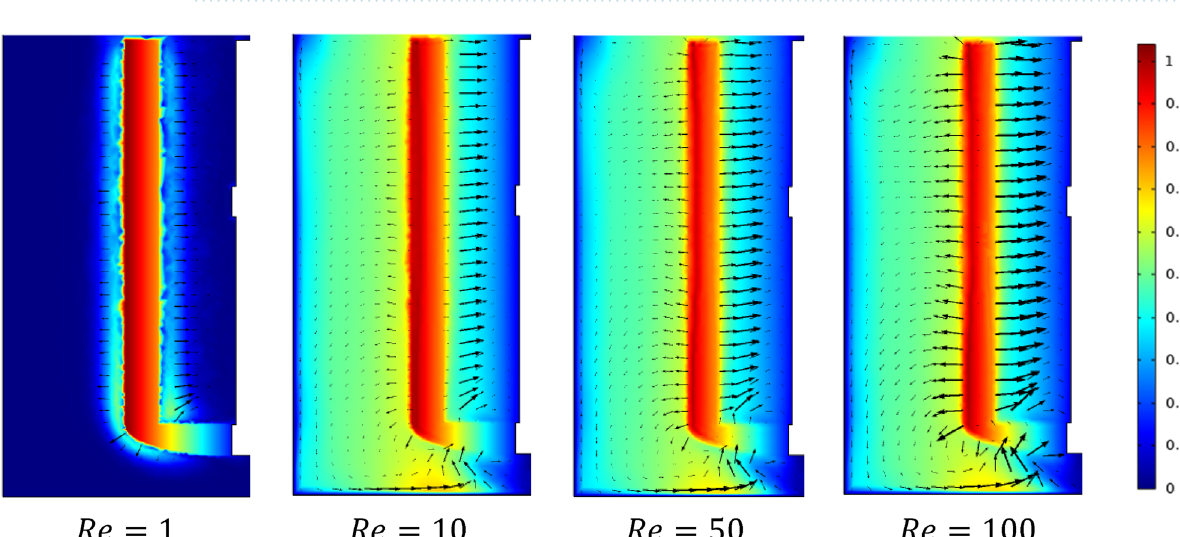
Figure 6. Contour velocity and arrow velocity filed distribution in the vertical impeller section on the stirred tank for different Reynolds